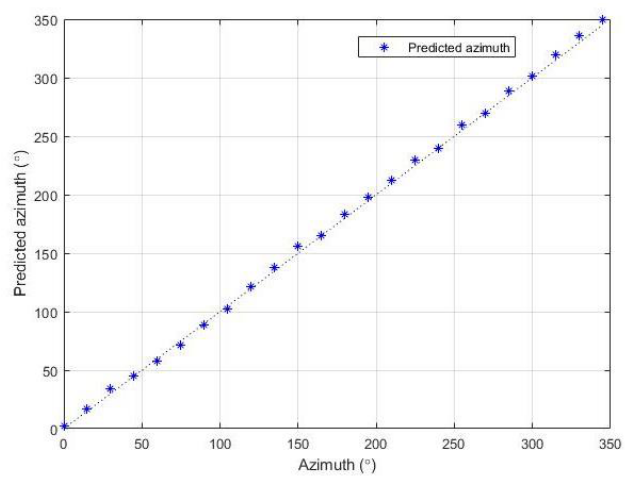
Figure 13. Predicted azimuth values compared to actual values.